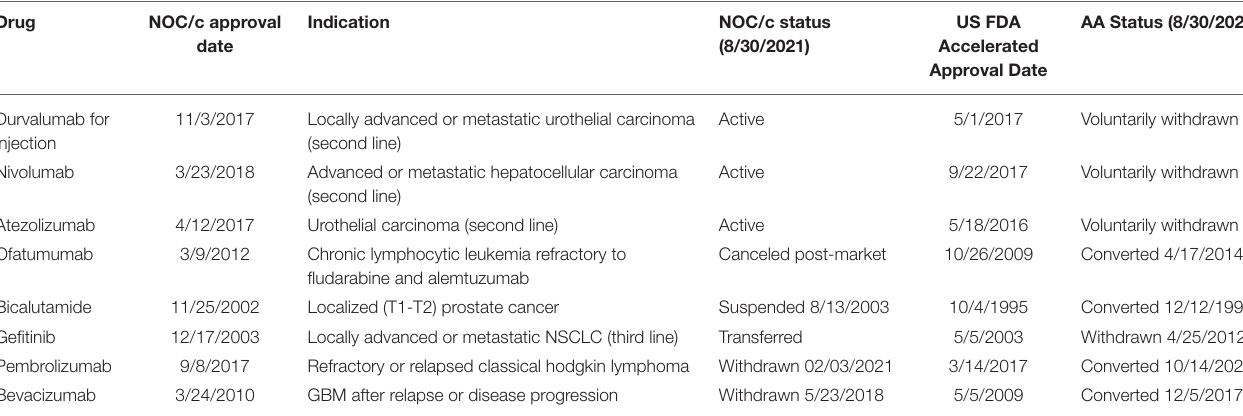
TABLE 1 | NOC/c and AA approvals, withdrawn in one jurisdiction.